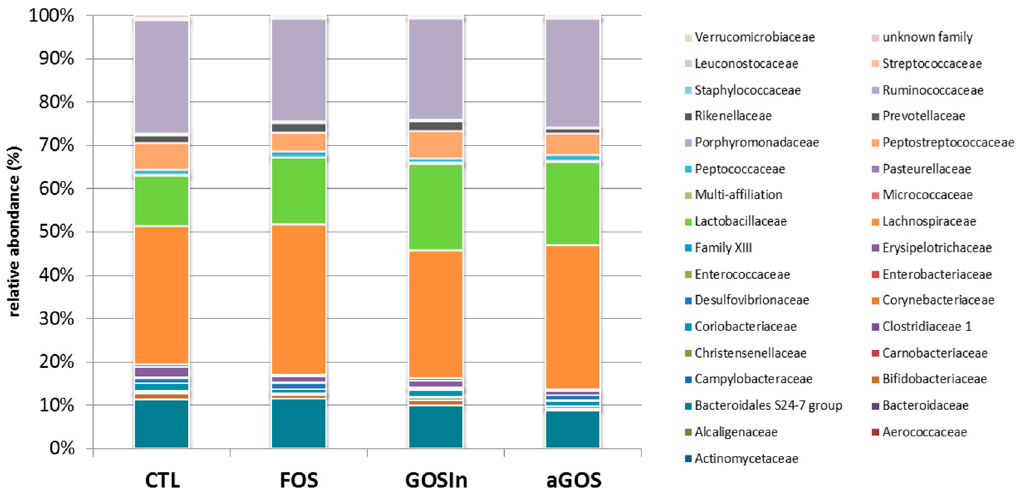
Figure 11. Impact of postnatal OS-supplementation on cecal microbiota composition at PND124/126: families distribution expressed as the average of cumulated relative abundances ( n = 7 to 8 per group).